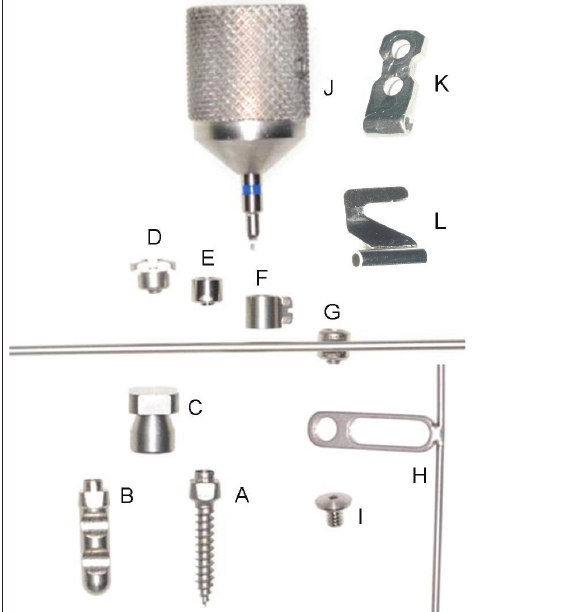
Figure 16. The Benefit Mini-Implant system and its constituent